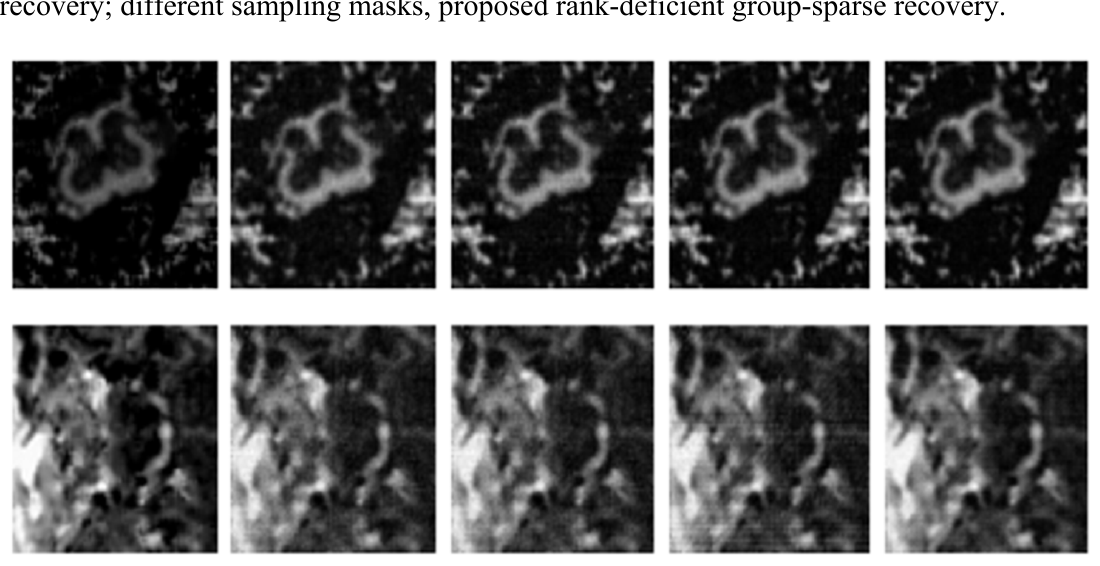
Figure 7. T2 maps for Ex vivo (top) and In Vivo (bottom) data; from left to right—Groundtruth, same sampling mask row-sparse recovery; same sampling mask, proposed rank-deficient row-sparse recovery; different sampling masks, group-sparse recovery; different sampling masks, proposed rank-deficient group-sparse recovery.